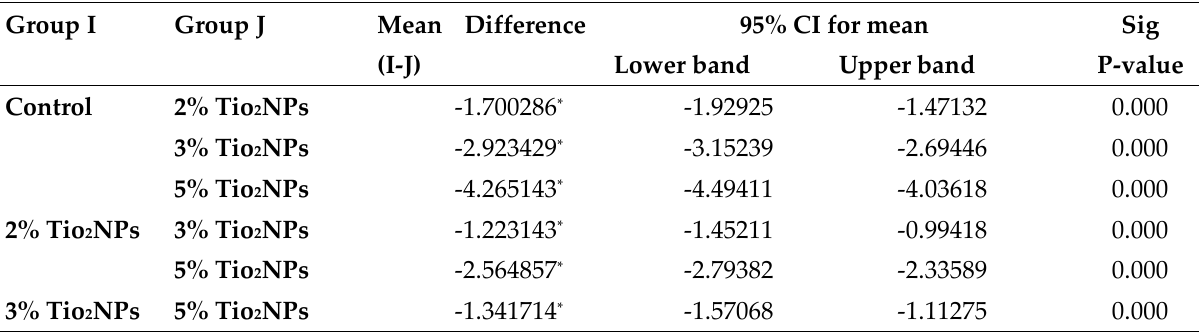
Table 2: Post hoc test ( LSD - multiple comparisons) for S. mutans